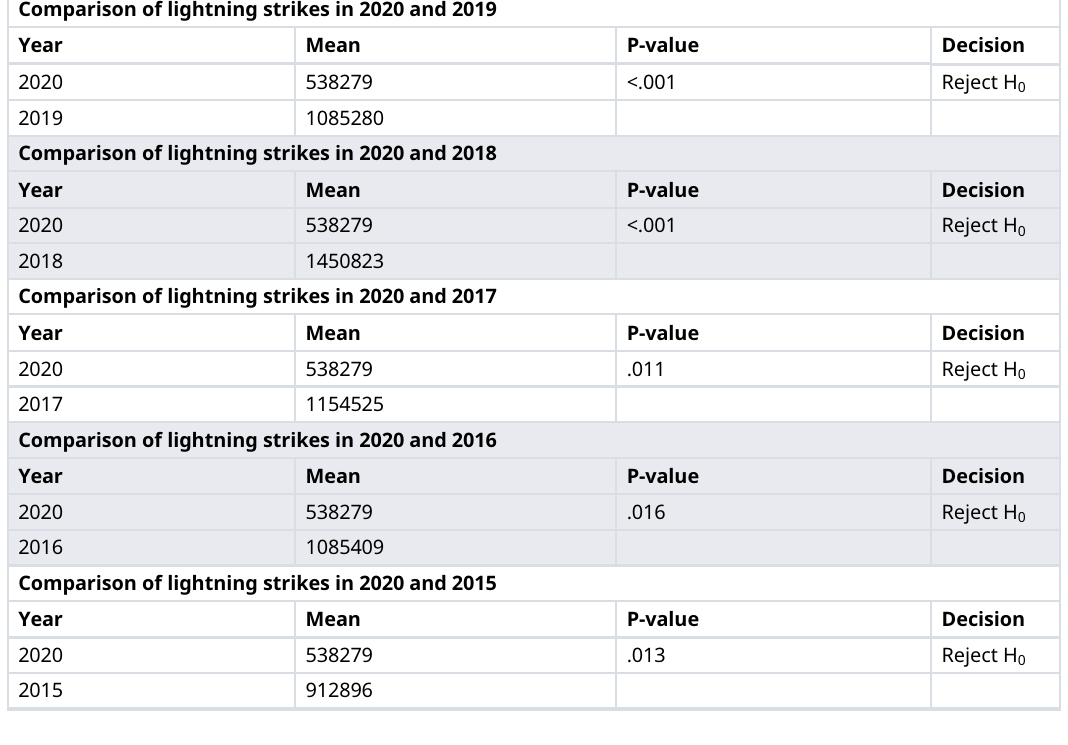
Table 5. t-test results comparing lightning strikes in 2020 with previous years in Europe.